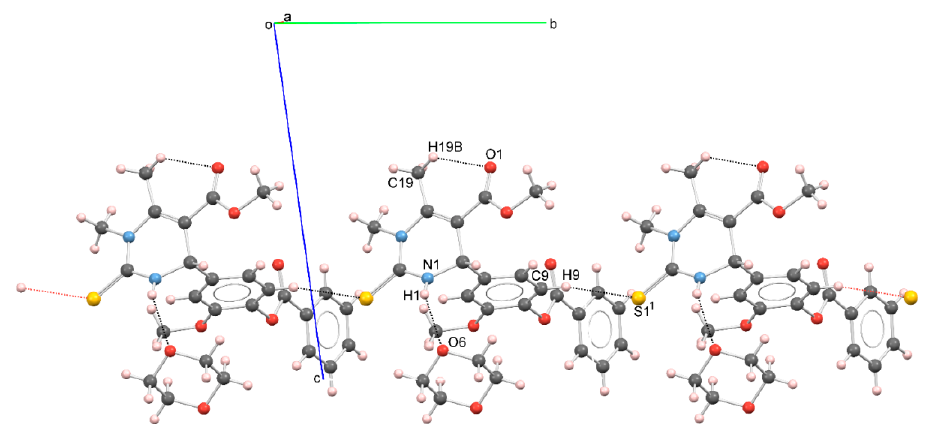
Figure 2. MERCURY [29] drawing showing crystal packing of 4-(4 ′ -benzoyloxy-3 ′ -methoxyphenyl)- 1,2,3,4-tetrahydro-1,6-dimethyl-2-thioxopyrimidine-5-carboxylate ( 4j ) viewed along the a axis. In- tramolecular N—H ••• O and C—H ••• O contacts are shown as dashed lines. Intermolecular C9— H9 ••• S1 1 (x, y+1, z) contacts (dashed line) connect molecules in a head-to-tail manner along the b axis.